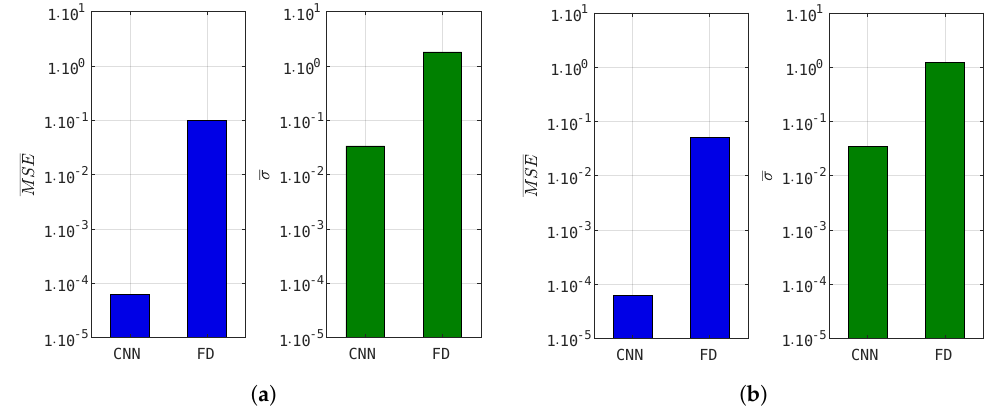
Figure 10. The MSE and σ of the best among the proposed approaches (CNN) and the best among the comparative methods (FD), from the Alfa Romeo Giulia experiments ( a ), and the Jeep Renegade experiments ( b ). Refer to Tables 2 and 4 for more